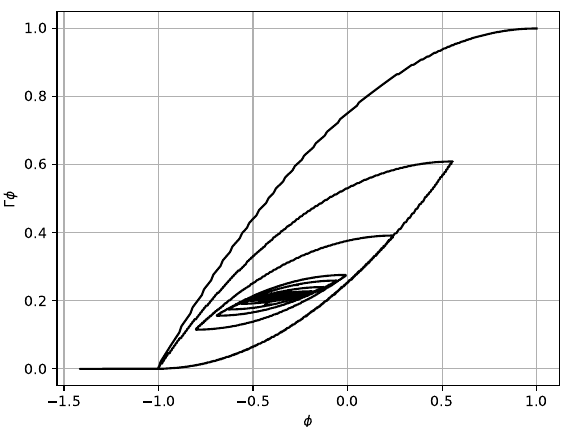
Figure 12. The dependence of Γ ϕ on ϕ at parameter values K = 2.0, ω = 1.2, Ω = 5.0, σ = 1.5, and H = 2.5. Initial conditions were ϕ ( 0 ) = 1, ψ ( 0 ) = 0, and σ ( 0 ) =